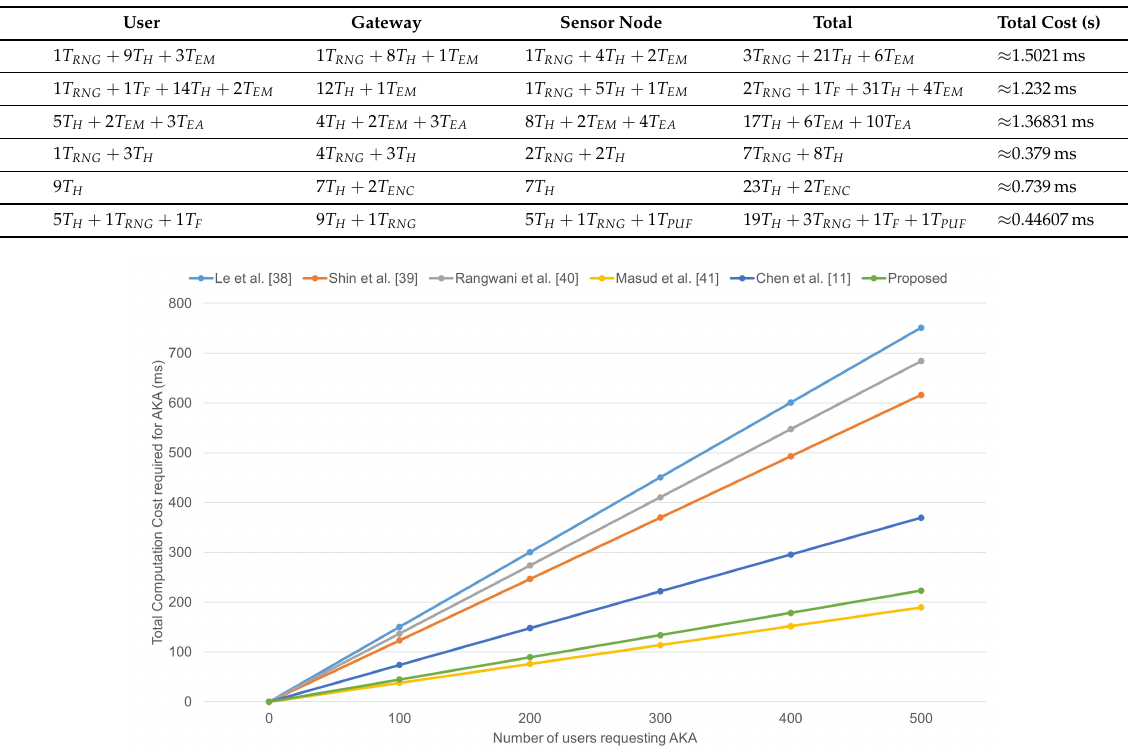
Table 6. Computational costs of each related scheme.